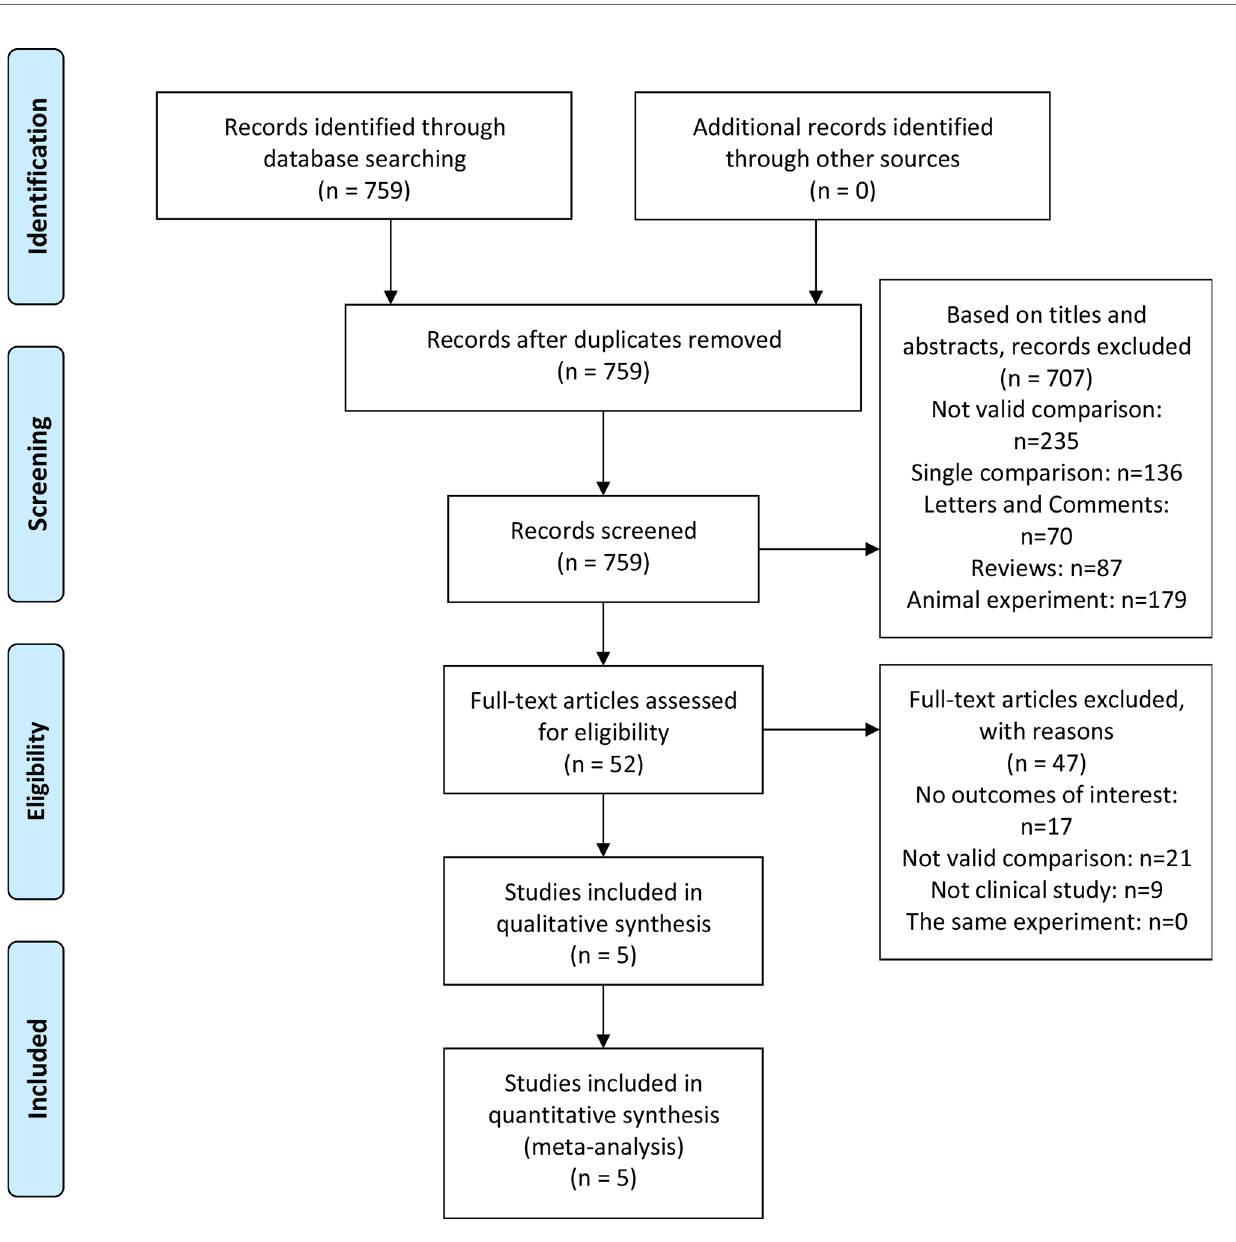
FIGURE 1 | PRISMA of selection